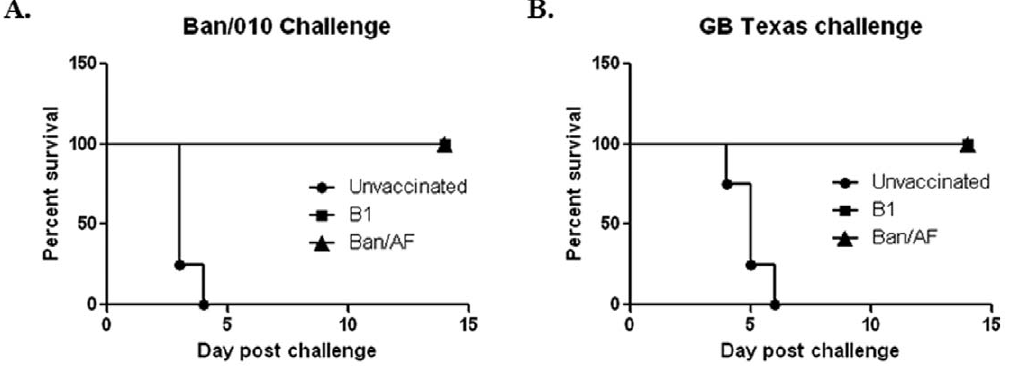
Figure 7. Protective efficacy of vaccine viruses Ban/AF and B1 in 1-day-old chicks against challenge with virulent strains Ban/010 and GB Texas. Chicks were inoculated with vaccine viruses Ban/AF or B1 by a single nasal drop each, or were mock-infected, as described in Materials and Methods. At 21 dpi, birds from each group were challenged with 100 LD50 of the Ban/010 or GB Texas viruses by the oculonasal route. The birds were observed daily for survival. Each challenge group had 10 birds except for the 1-day-old chicks immunized with Ban/AF, which had 12 birds in the Ban/010 challenge group and 11 birds in the GB Texas challenge group. doi:10.1371/journal.pone.0052751.g007 PLOS ONE |